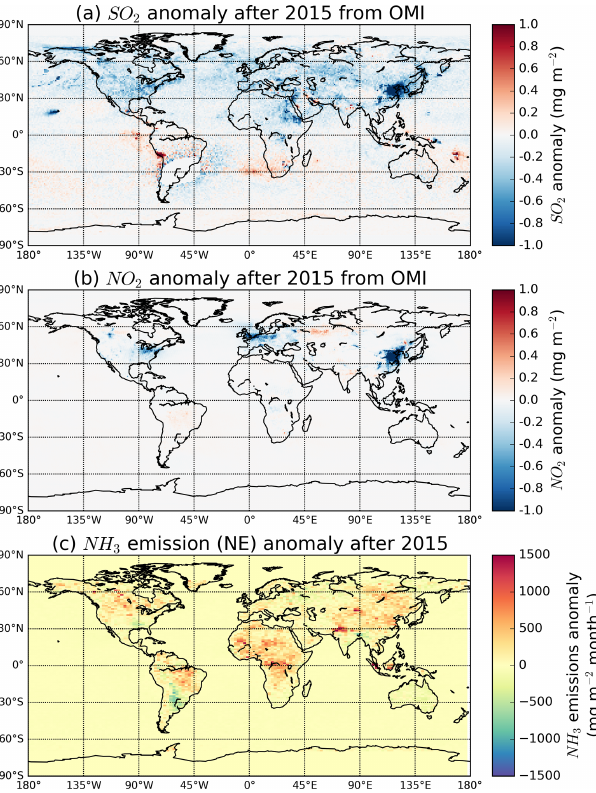
Figure 2. Annual average total column (a) sulfur dioxide and (b) ni- trogen dioxide anomaly after 2015 from OMI and (c) annual av- erage emission anomaly of ammonia calculated from IASI in the present study